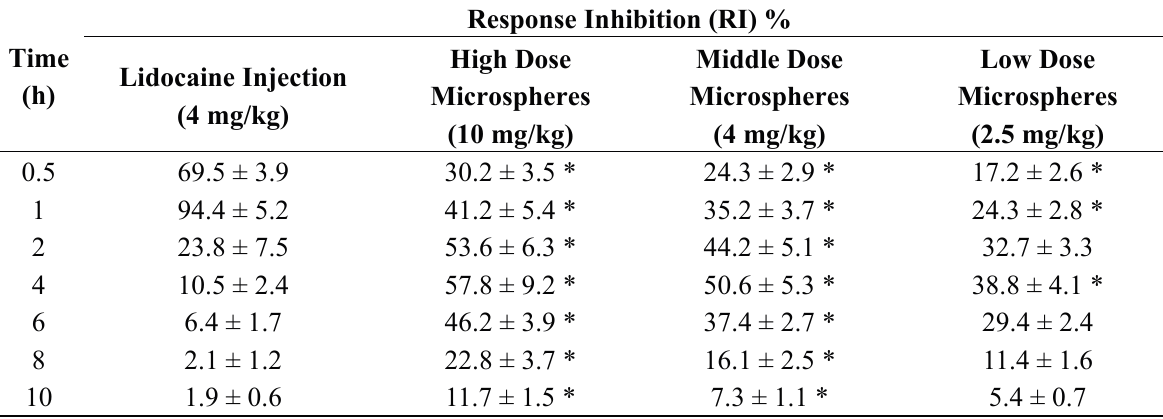
Table 2. The analgesic efficacy of lidocaine microspheres and lidocaine injection on rats.